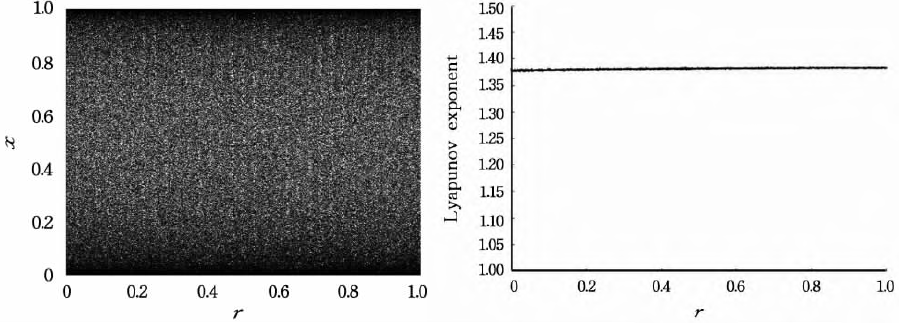
Figure 3. Bifurcation graph and Lyapunov exponent of logistics-sine-cosine mapping.